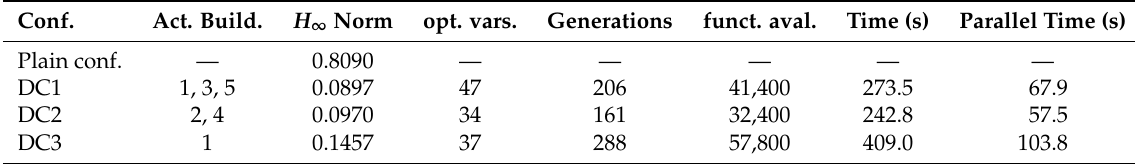
Table 2. Computational design characteristics of the linked DDS configurations DC1, DC2 and DC3. Conf. Act. Build. H ∞ Norm opt. vars. Generations funct. aval. Time (s) Parallel Time (s) Plain conf. — 0.8090 — — — —